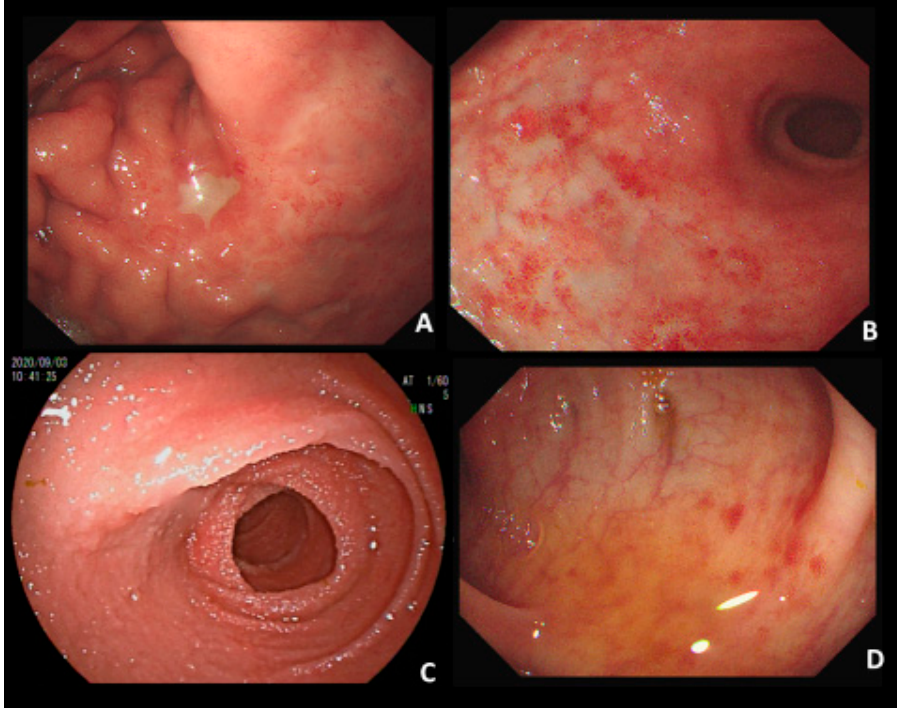
Figure 1. The endoscopy revealed MALToma in the stomach ( A ), duodenum ( B ), terminal ileum ( C ), and sigmoid ( D ).